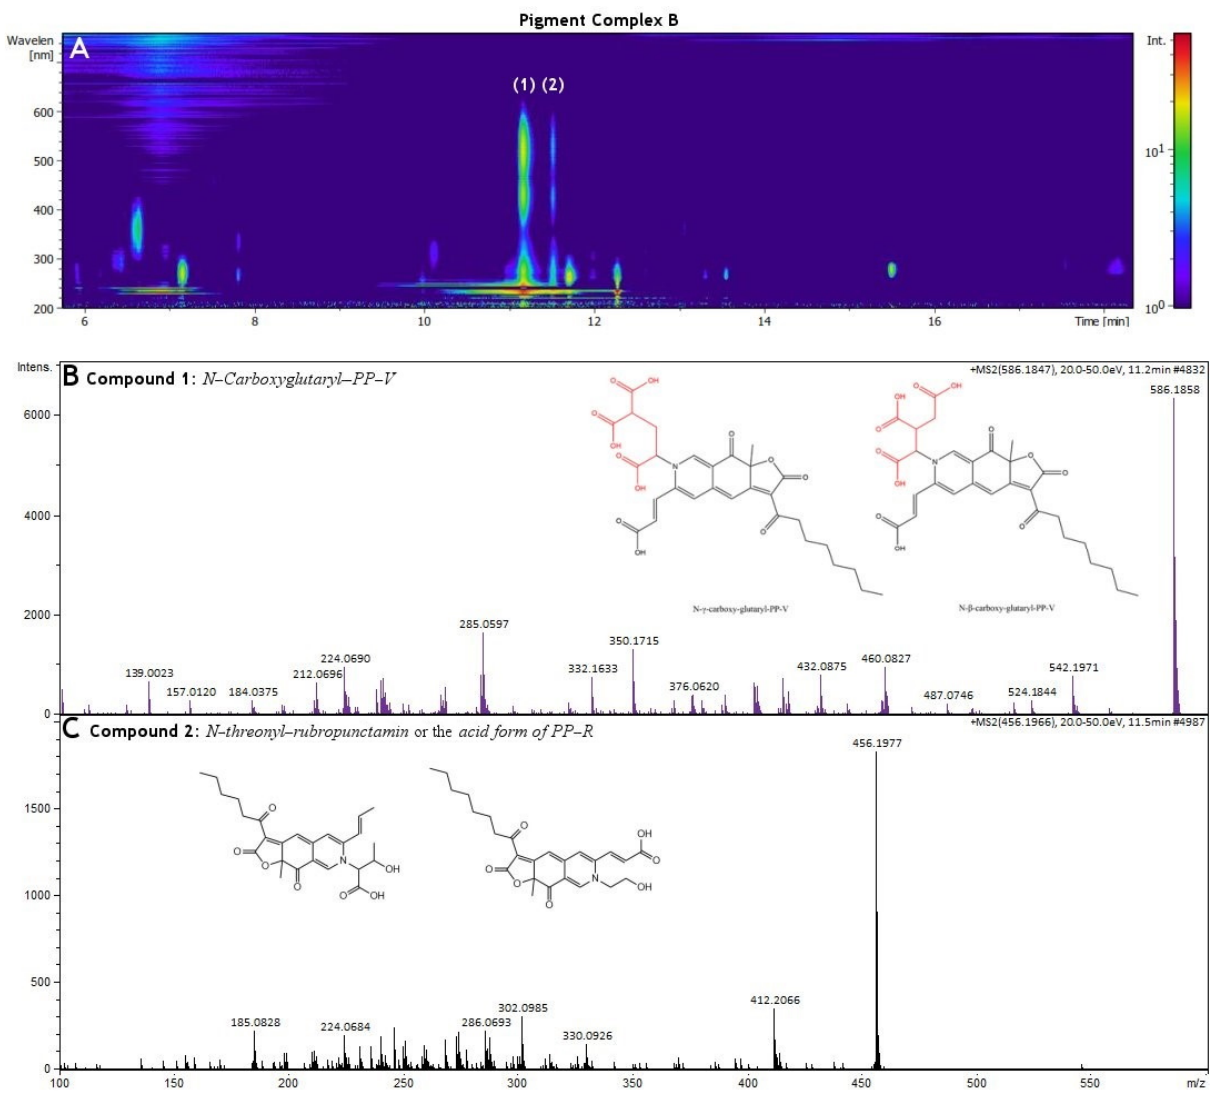
Figure 5. ( A ) Illustration of different compounds (Compound 1 – 2 ) that were detected using UHPLC-DAD chromatog- raphy of Pigment Complex B. ( B ) ESI + -MS fragment of Compound 1 ( N-carboxyglutaryl-PP-V), ( C ) ESI + -MS fragment of Compound 2 ( N-threonyl-rubropunctamin or the acid form of